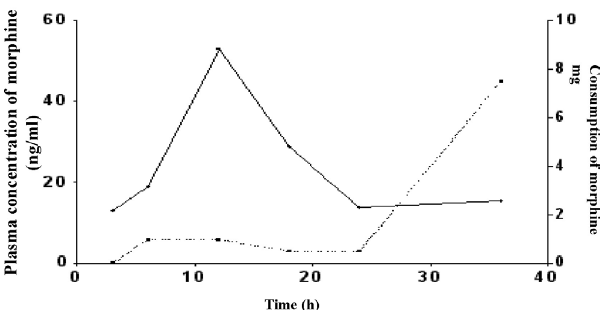
Figure 3 - Curve of plasma concentrations of morphine obtained as a func- tion of time after extubation in the group of study (n = 4) considering the dose of morphine PCA consumed at each interval. Population data expressed as medians: (__) plasma concentration, (--) consumption of morphine up to 36